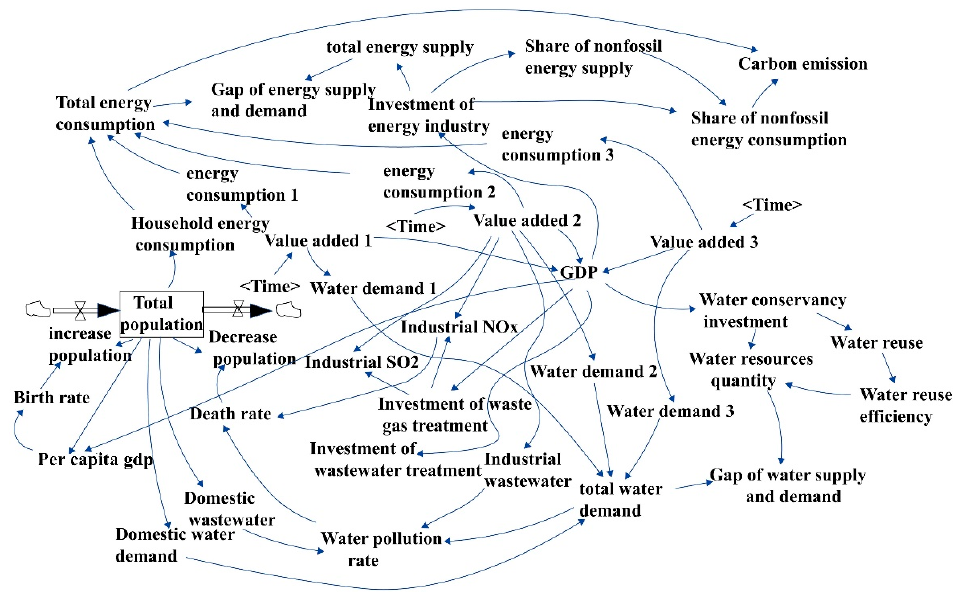
Figure 2. Diagram of relationships between variables in the regional urban metabolism model via the water ‐ energy ‐ population nexus in Hebei province.